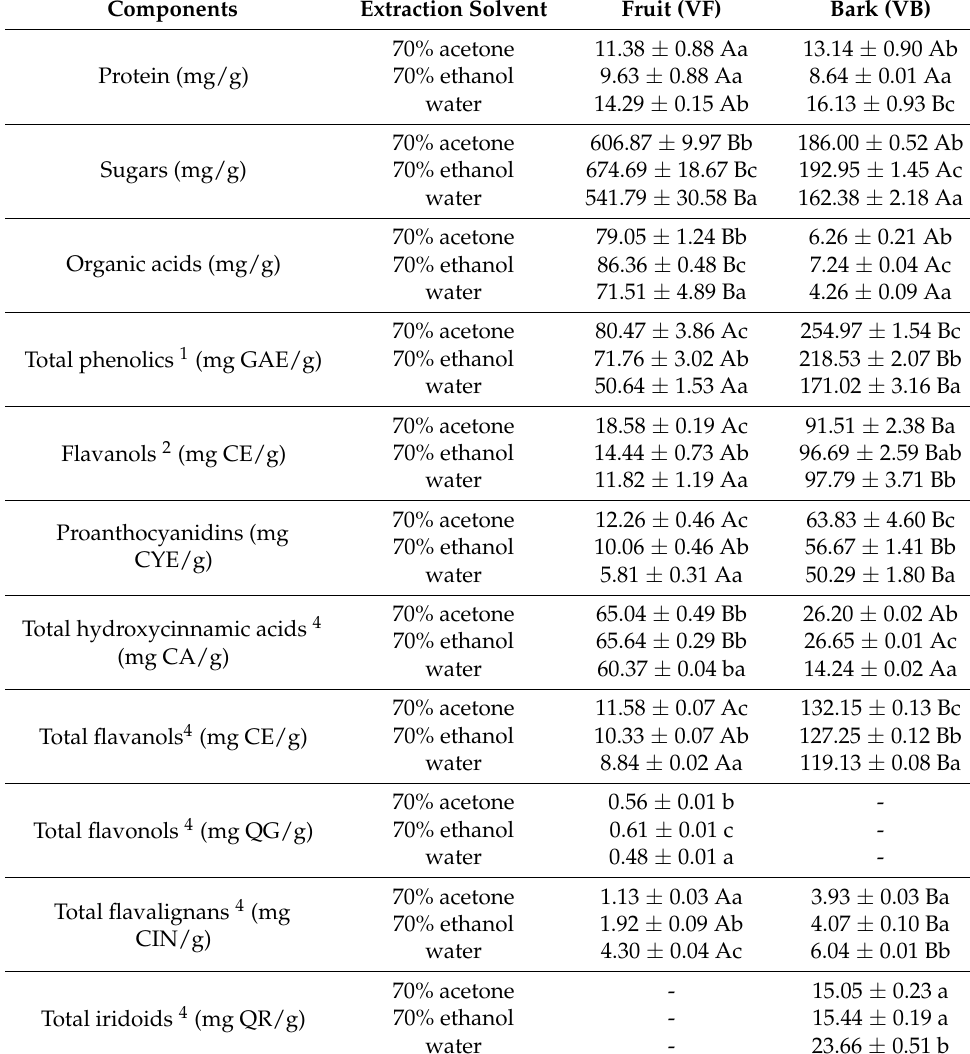
Table 1. Chemical composition of V. opulus fruit and bark